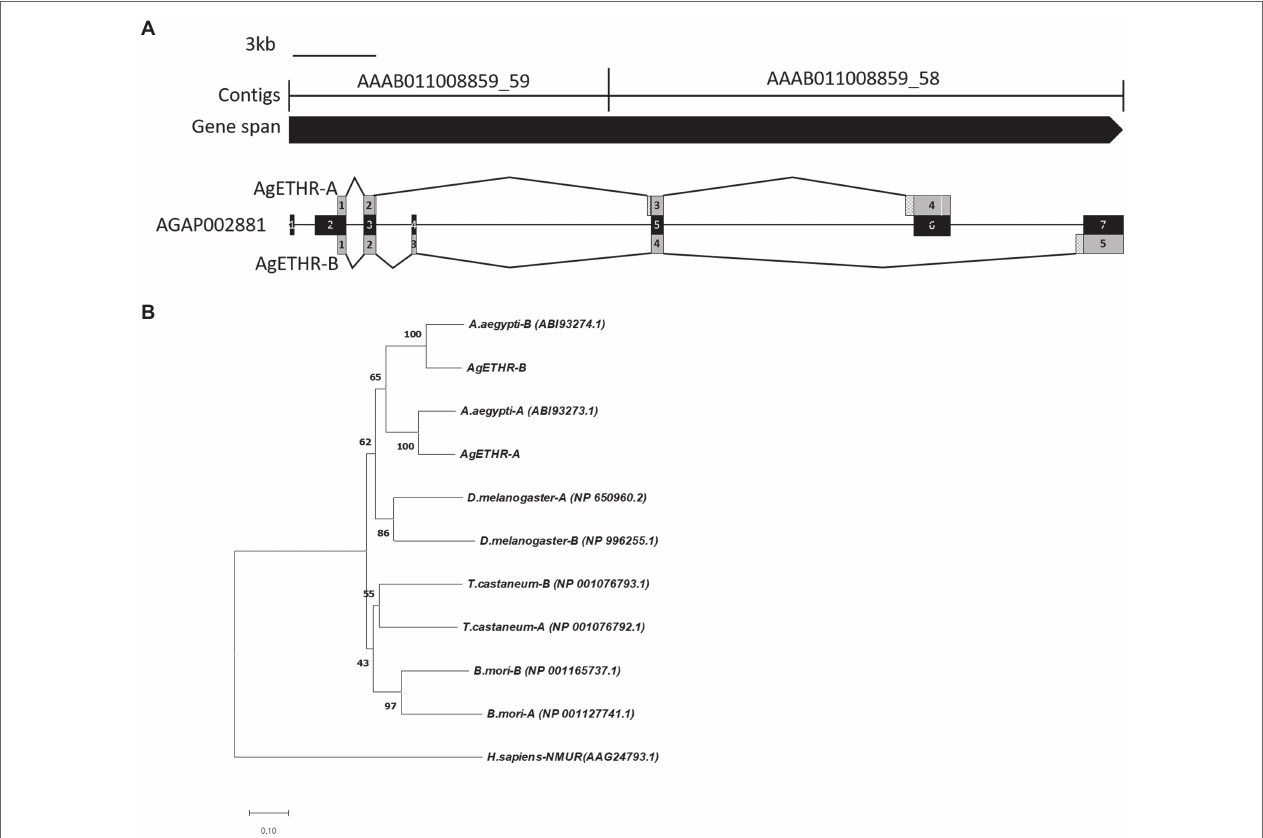
FIGURE 1 | Gene structure and phylogenetic relationship of the AgETH receptors. (A) Gene structure of ecdysis triggering hormone receptors (AgETHR-A and AgETHR-B). Empty boxes in exons of AgETHR-A indicated 4 bp and 3 bp fragment deletion. Checkered boxes before exon 3 and 4 of AgETHR-A and exon 5 of AgETHR-B indicate the 5 bp, 51 bp, and 84 bp fragment insertion. (B) Phylogenetic relationship of ETH receptors from Anopheles gambiae, Aedes aegypti, Drosophila melanogaster, Tribolium castaneum, and Bombyx mori . Neuromedin U receptor of Homo sapiens was used as an outgroup. The tree was constructed using the Neighbor-Joining method using MEGA7. The percentage of replicate trees in which the associated taxa clustered together in the bootstrap test (1,000 replicates) is shown next to the branches. The evolutionary distances were computed using the Poisson correction method. All positions containing gaps and missing data were